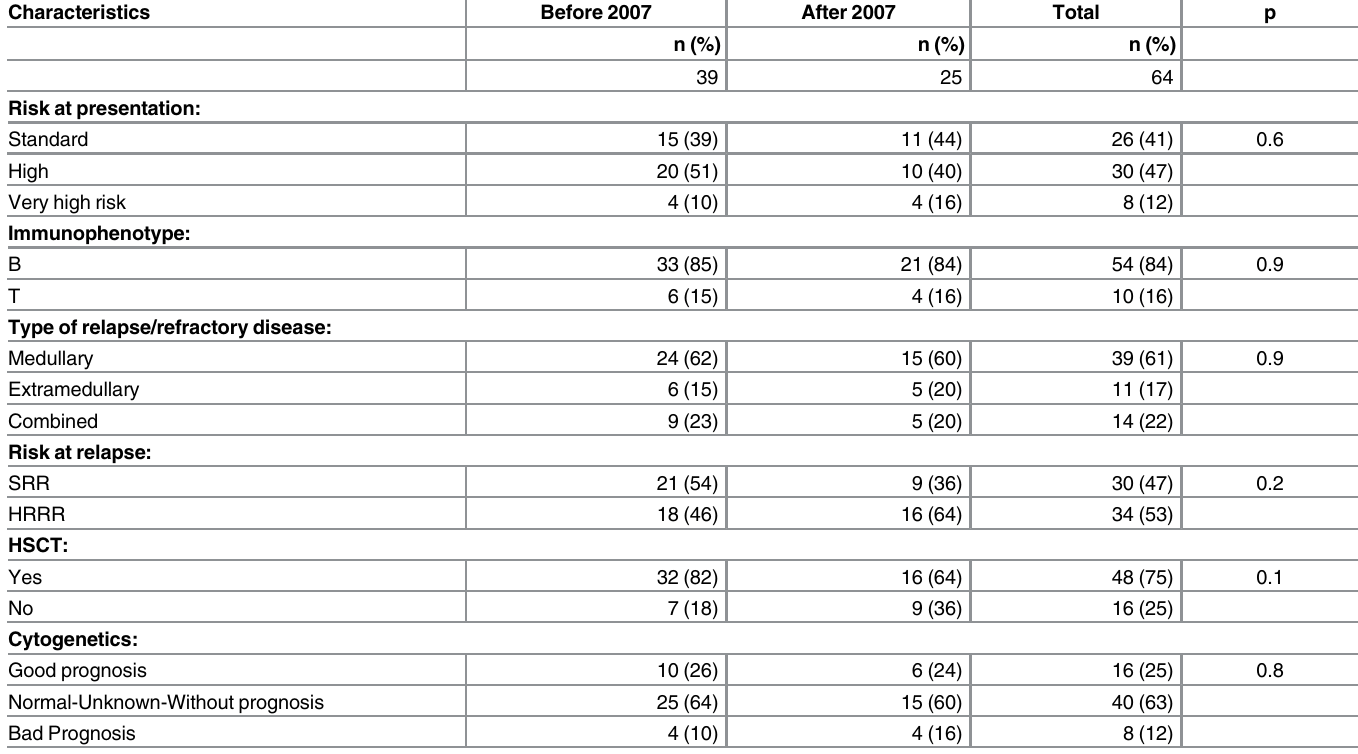
Table 2. Characteristics of relapsed or refractory patients at diagnosis of relapse or refractory disease.